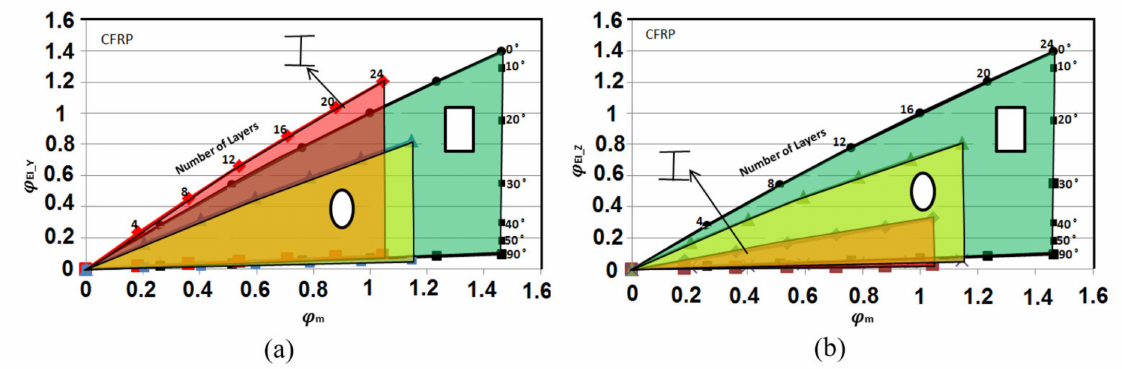
Figure 6. Normalized bending stiffness versus mass ratio: ( a ) in the Y -direction and ( b ) in the Z